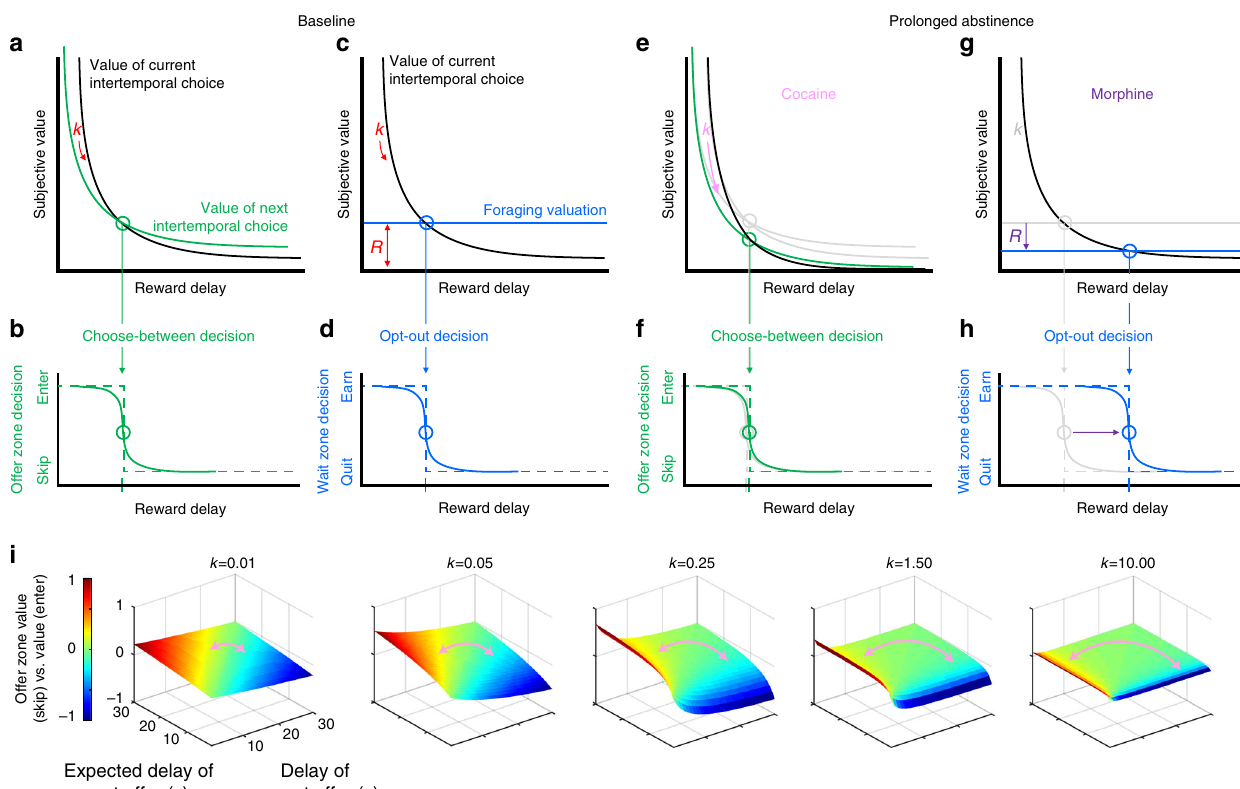
Fig. 4 Neuroeconomic modeling of separable computation-speci fi c changes in decision con fl ict valuation algorithms. a – d Baseline. a Deliberative model: hyperbolic temporal discounting function of the current choice (black) is compared against a second hyperbolic temporally discounted function of the expected next choice (green), with a discounting rate k (red). b Offer zone choose-between thresholds are derived from this intersection. c Foraging model: hyperbolic temporal discounting function (black) of work remaining with discounting rate k (red) is compared against the average opportunity cost of reward availability in the rest of the environment, y -intercept R (red). d Wait-zone opt-out thresholds are derived from this intersection. e – i Modeling the effect of our drug delivery and forced abstinence manipulation. e Our data in mice with a history of repeated cocaine exposure are consistent with an increase in the k parameter in offer-zone deliberative valuation model, which yields no change in offer-zone thresholds ( f ), but yields increased indecision particularly for economically unfavorable high cost offers ( i ). g Our data in mice with a history of repeated morphine exposure are consistent with a decrease in the R parameter in the wait-zone foraging valuation model, which leads to an increase in the wait-zone threshold ( h